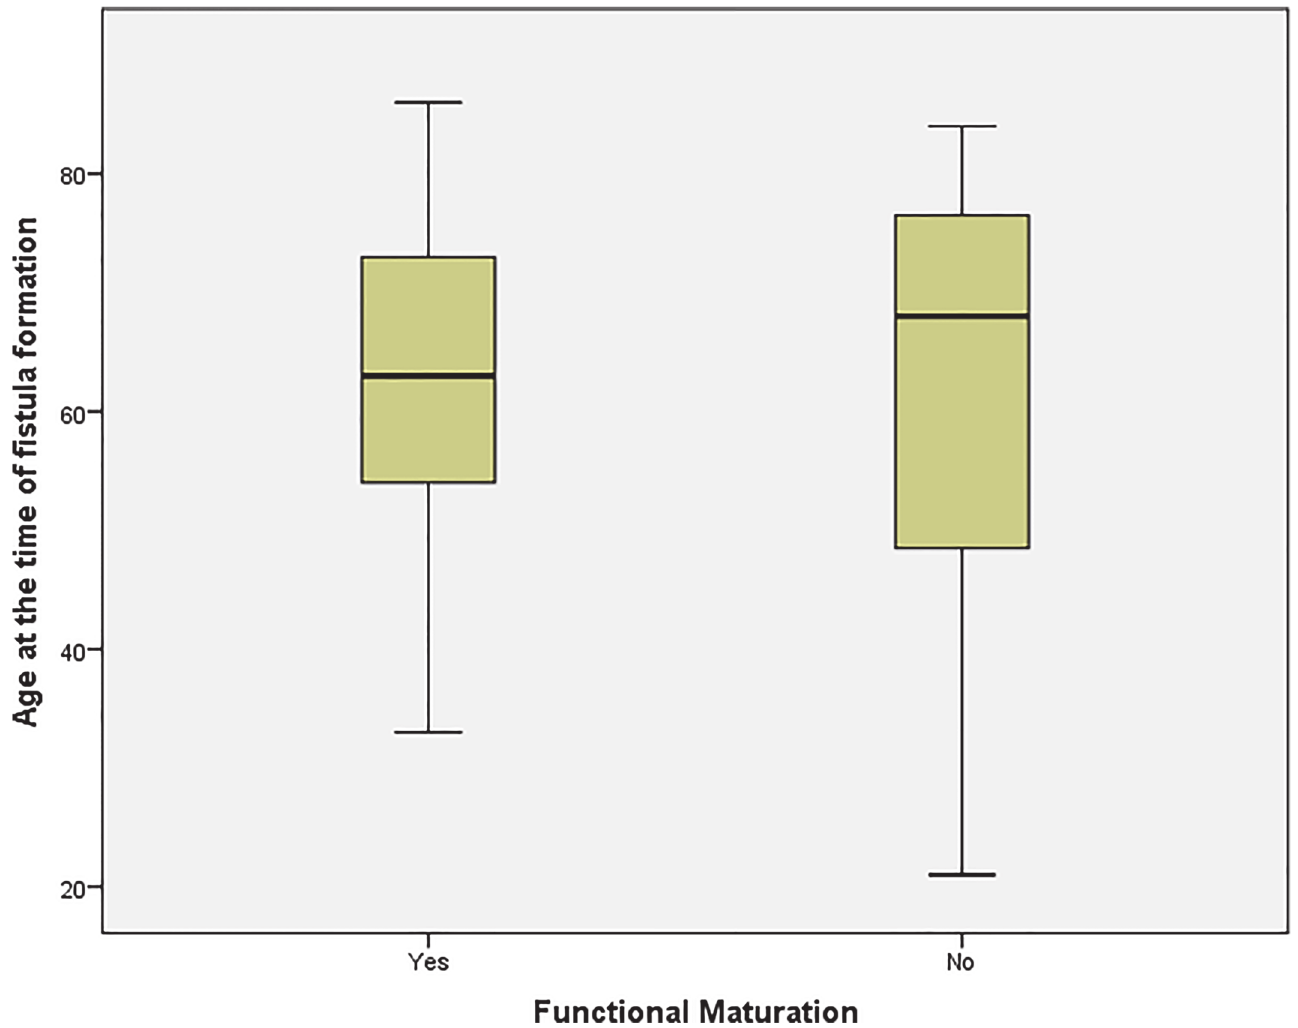
Fig 4. Variation in age between mature and non-mature AVF